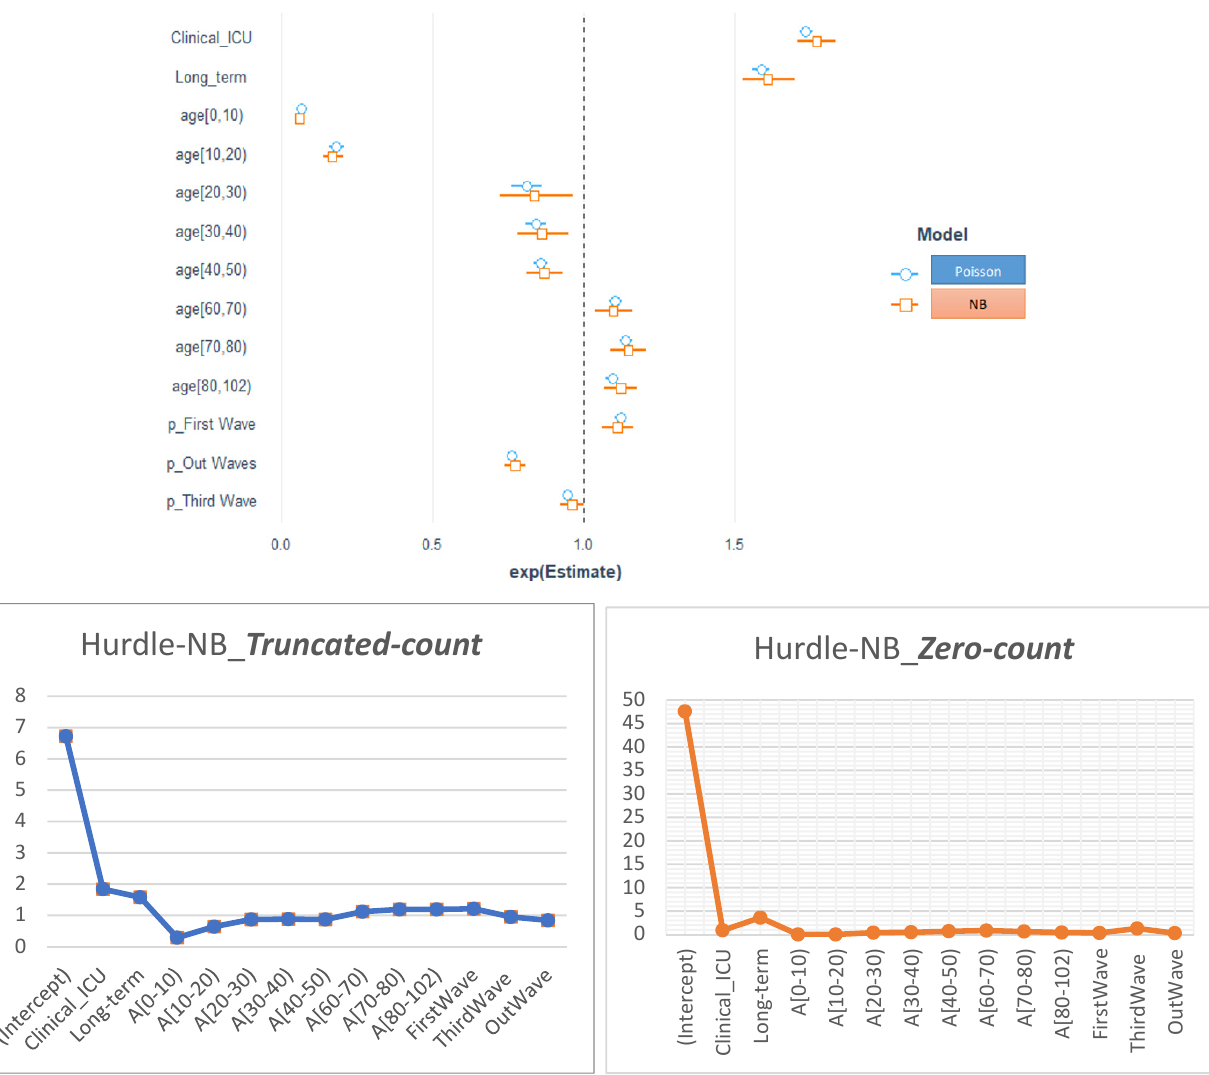
Figure 6. Visualization of IRR for the Poisson and NB models ( top panel), and the Hurdle–NB truncated ( bottom left ) and zero ‐ count effect plots ( bottom right ).